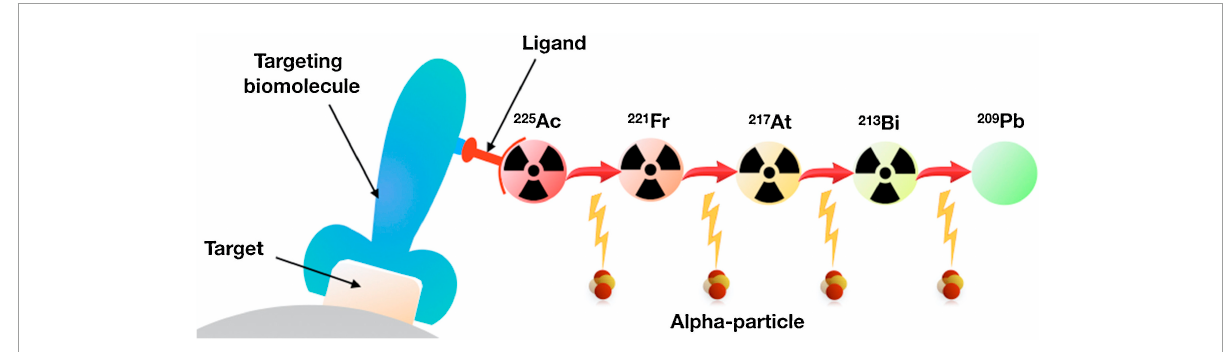
FIGURE1 Schematic representation of targeted radiotherapy. In targeted alpha therapy, the targeting vector is conjugated with a ligand chelating an α -emitter, such as 225 Ac, which emits four α -particles down to stable 209 Pb. Adapted with permission from ref 2. Copyright 2018